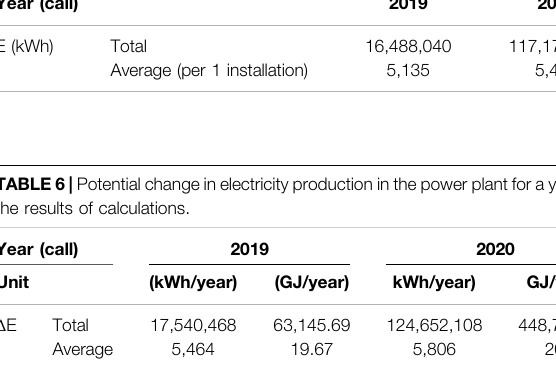
TABLE 7 | Potential ecological effect, obtained thanks to the installation of photovoltaic micro-installations in single-family buildings in Ma ł opolska – calculation results.